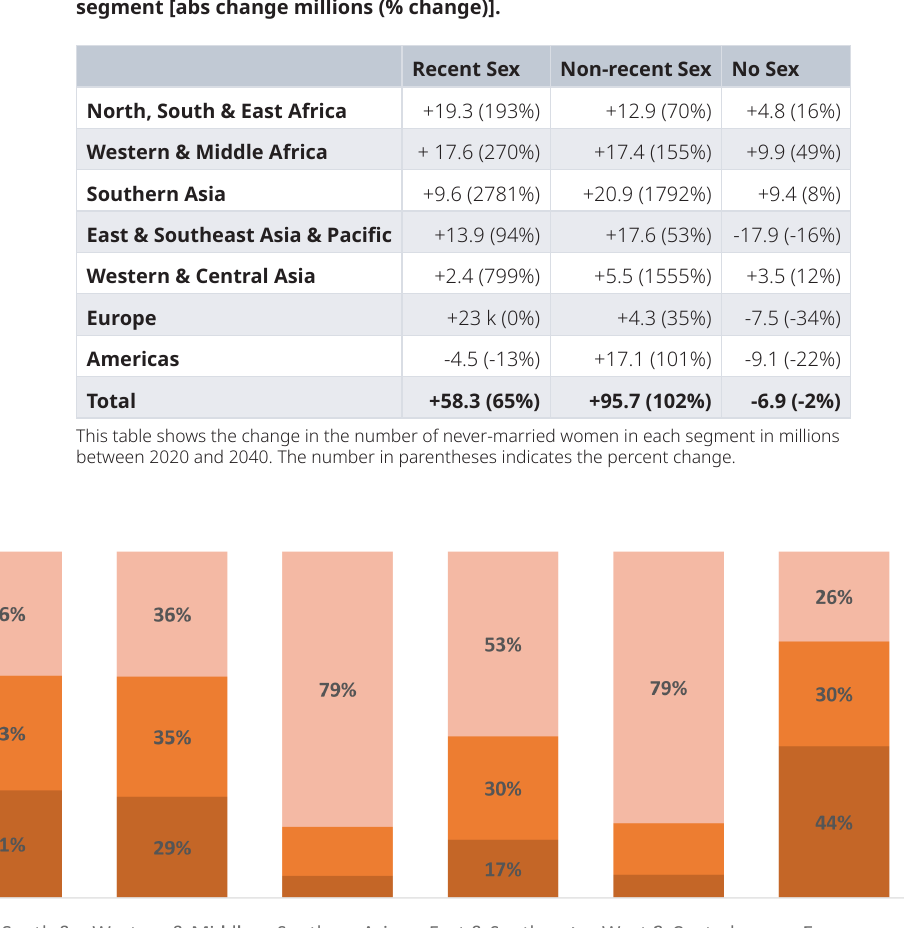
Table 5. Change in never-married women from 2020 to 2040 by market segment [abs change millions (% change)].